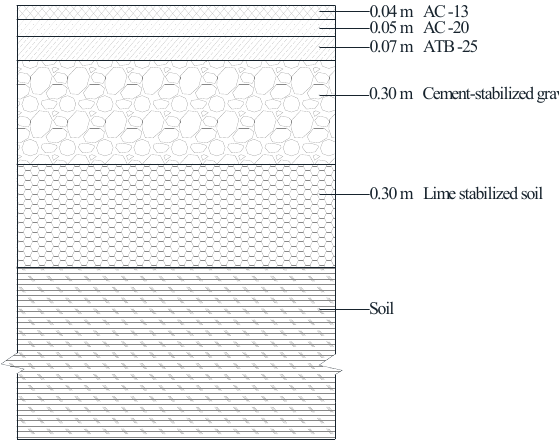
Figure 1. Lanzhou BRT asphalt pavement structure.